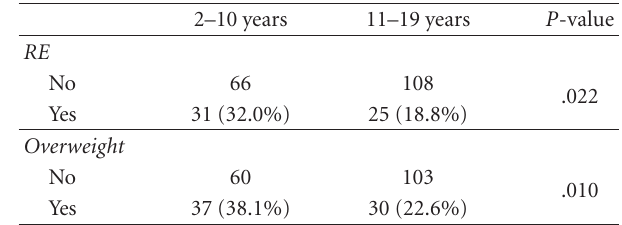
Table 4: Prevalence of RE and overweight based on age